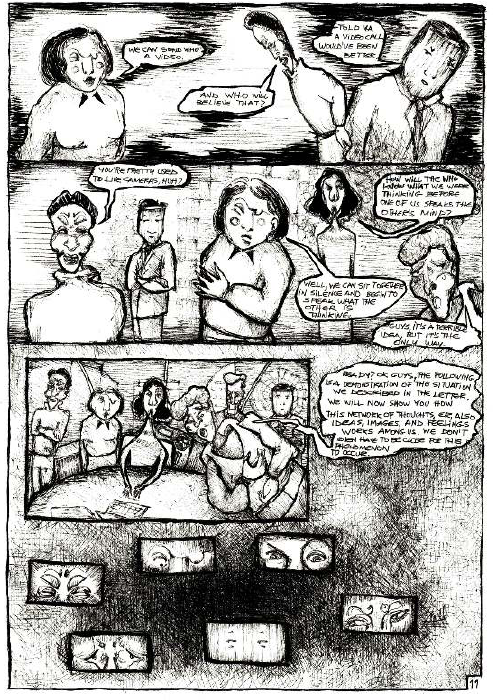
Credits: Amine Barbuda.